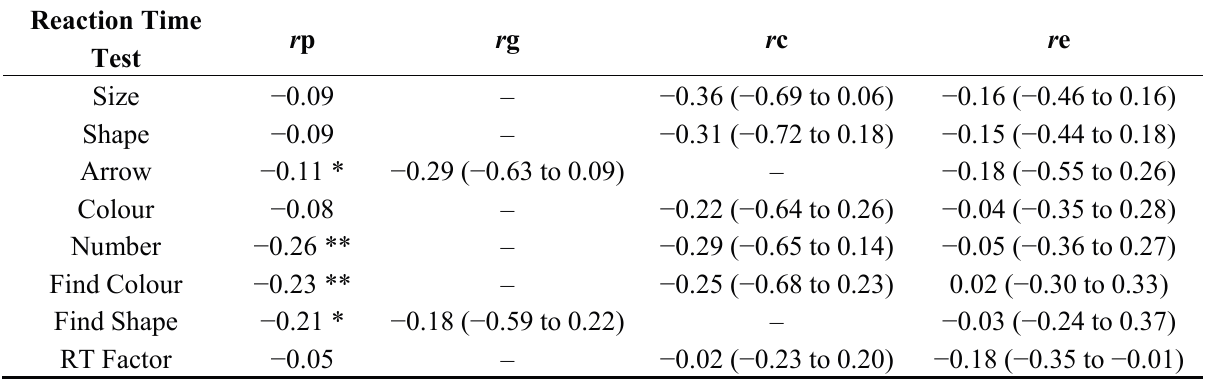
Table 2. Phenotypic, Genetic, and Environmental Correlations between Ravens and Reaction Time